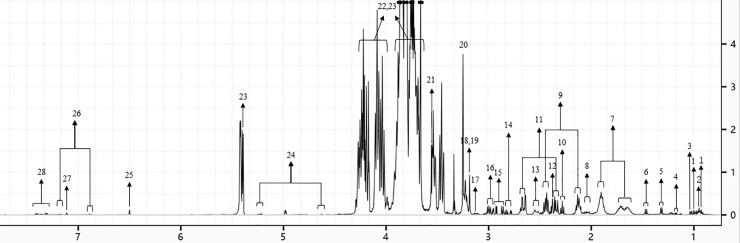
A representative 1H-NMR spectrum of the metabolites identified in Jerusalem artichoke tubers.(1) isoleucine, (2) leucine, (3) valine, (4) ethanol, (5) threonine, (6) alanine, (7) arginine, (8) glutamate, (9) glutamine, (10) 4-aminobutyrate, (11) malate, (12) succinate, (13) citrate, (14) aspartate, (15) asparagine, (16) 2-oxoglutarate, (17) malonate, (18) choline, (19) O-phosphocholine, (20) betaine, (21) glycine, (22) fructose, (23) sucrose, (24) glucose, (25) fumarate, (26) tyrosine, (27) histidine, (28) phenylalanine.